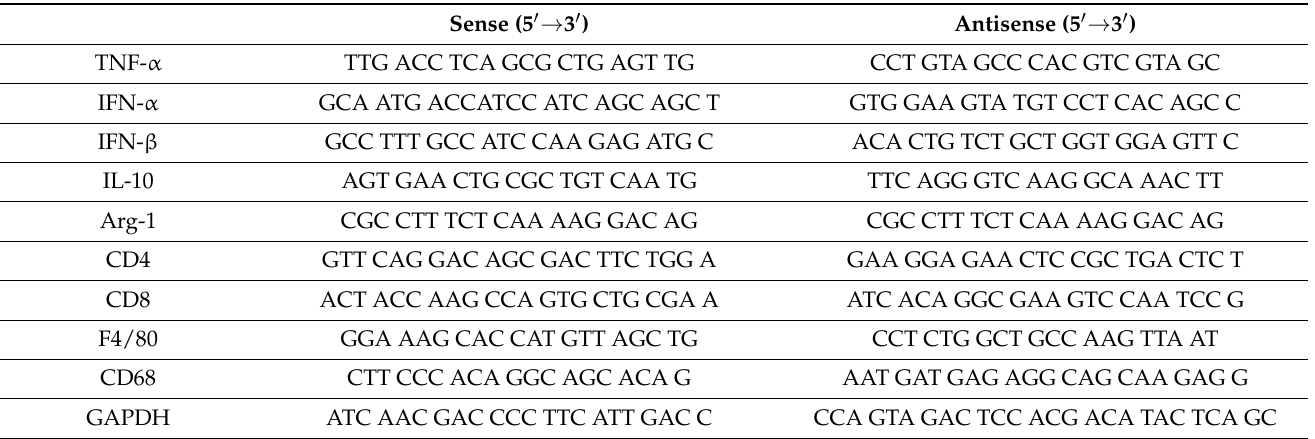
Table 1. Cont. Sense (5 (cid:48) → 3 (cid:48) ) Antisense (5 (cid:48) → 3 (cid:48)